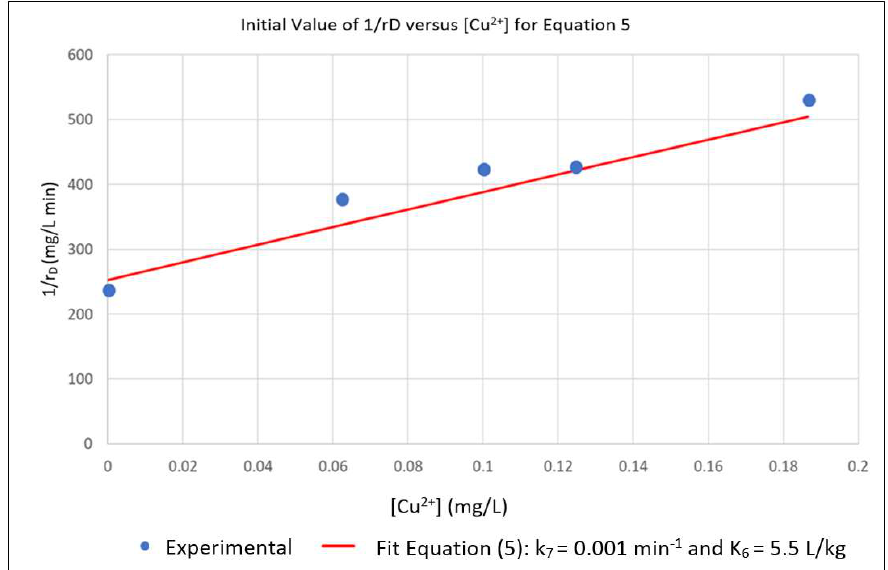
Figure 2. Nonlinear Multiple Regression of Experimental r D in Terms of k 7 and K 6 .